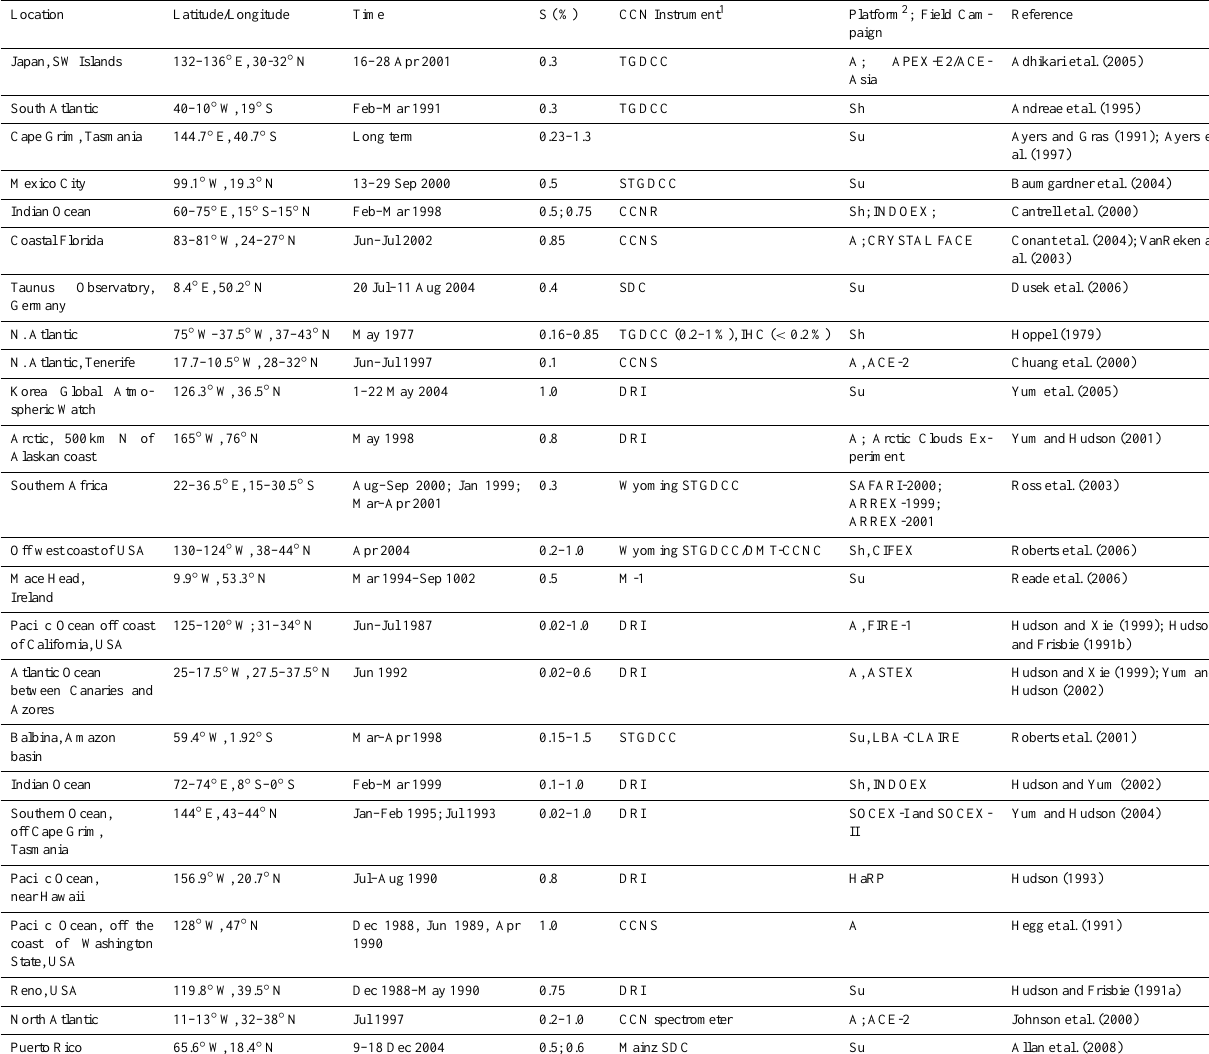
Table 1. CCN observations (supersaturation, S) from the literature that are used in this analysis.